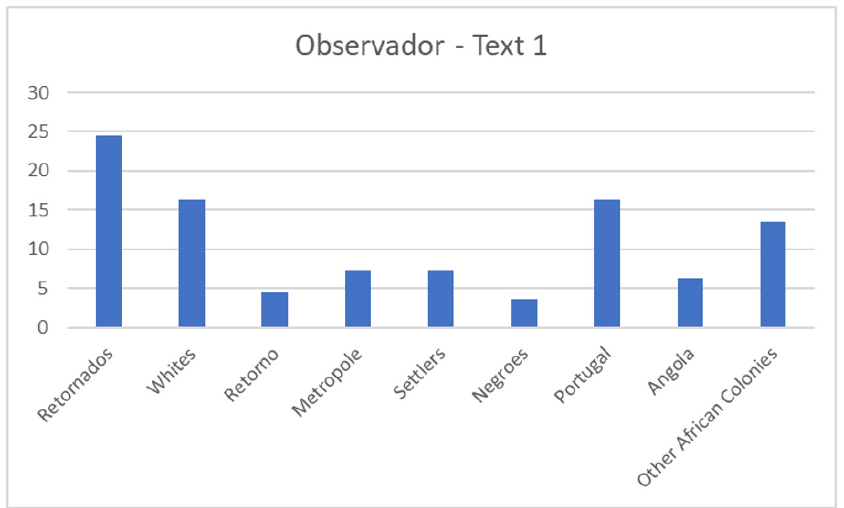
Figure 3. Words most commonly used in the text “Os retornados começaram a chegar há 40 anos”.